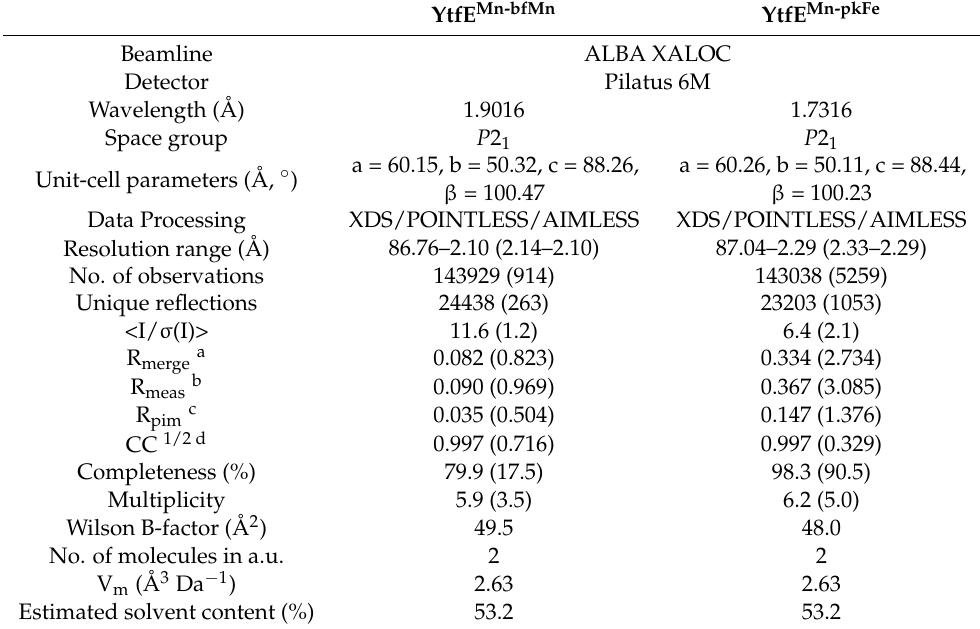
Figure 5. Analyses of fluorescence scans near the K-absorption edges of Fe and Mn using CHOOCH ( A ) Fe edge from a crystal of YtfE wt ; ( B ) Mn edge from a crystal of YtfE Mn . Table 6. Data collection and processing statistics for the crystal structures of E. coli YtfE wild type with manganese in the metal site YtfE Mn , collected before the Mn K-edge (YtfE Mn-bfMn ) and at the Fe K-edge peak (YtfE Mn-pkFe ).